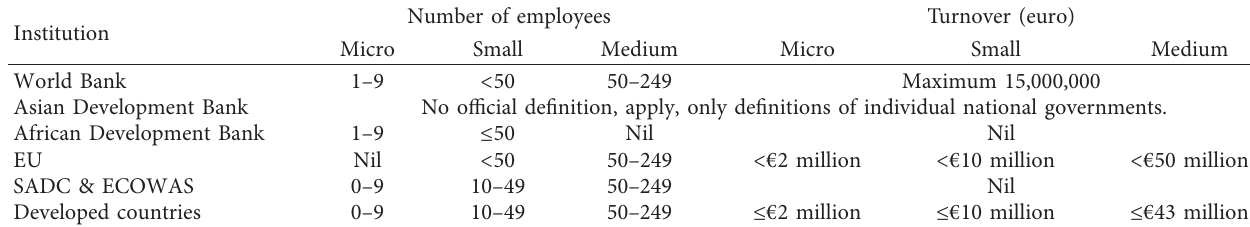
Table 1: SME definitions used by multilateral